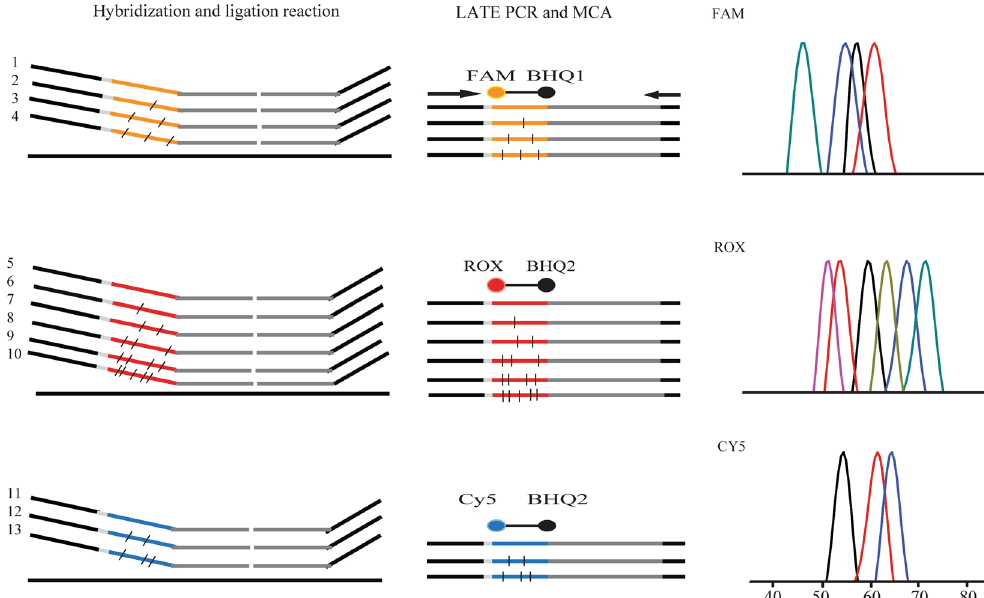
Figure 1. MLMA assay for the identification of ten bacterial pathogens in a single reaction. During the ligation process, 13 pairs of ligation oligonucleotides were hybridized onto the target genes of ten bacterial pathogens and one internal control (IC). In the LATE-PCR/MCA step, the ligated products were amplified by one pair of universal primers in the presence of three differently labeled fluorogenic probes; after PCR amplification, the unique Tm value was obtained via the MCA. FAM: IAC, P . shigelloides , Aeromonas , V . parahaemolyticus ( tdh ); ROX: V . cholerae , V . fluvialis , V . vulnificus , V . parahaemolyticus , V . mimicus , V . alginolyticus; Cy5: O1 V . cholerae , O139 V . cholerae , V . cholerae ( CTX